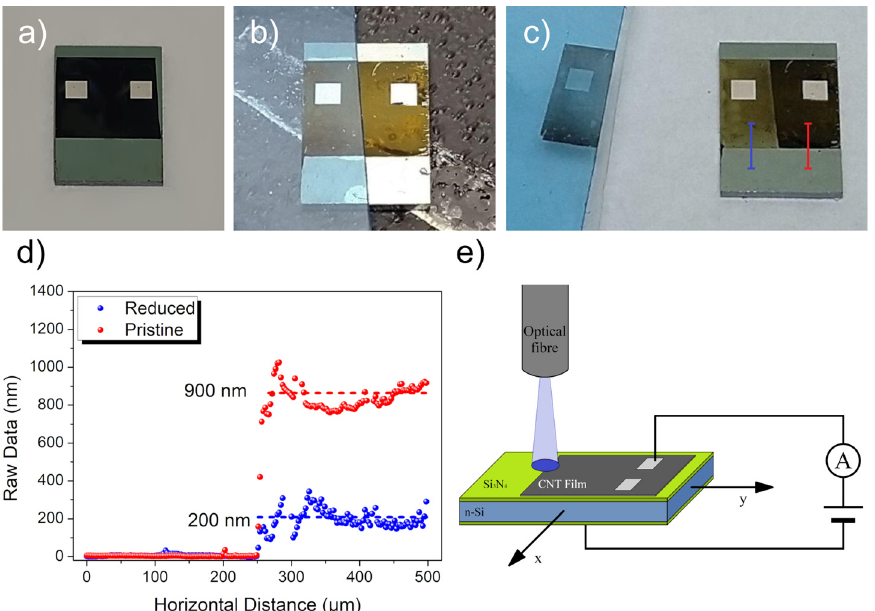
Figure 1. MWCNT film-thinning process: ( a ) device with pristine MWCNT film, ( b ) scotch tape adhered to half area of the device, and ( c ) tape peeled off from the device. ( d ) The thickness of the MWCNT film along the lines in ( c ). ( e ) The layout of the device and the setup used for the photo-response characterization as a function of the light spot position.